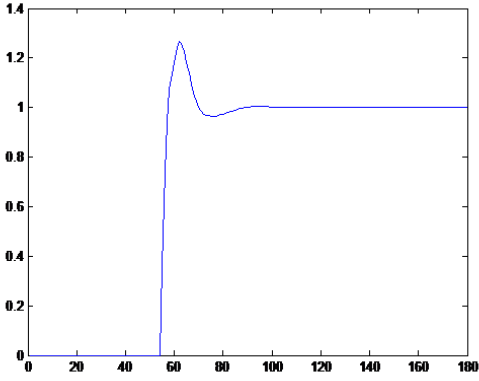
Figure 13. Step response for 40% step input